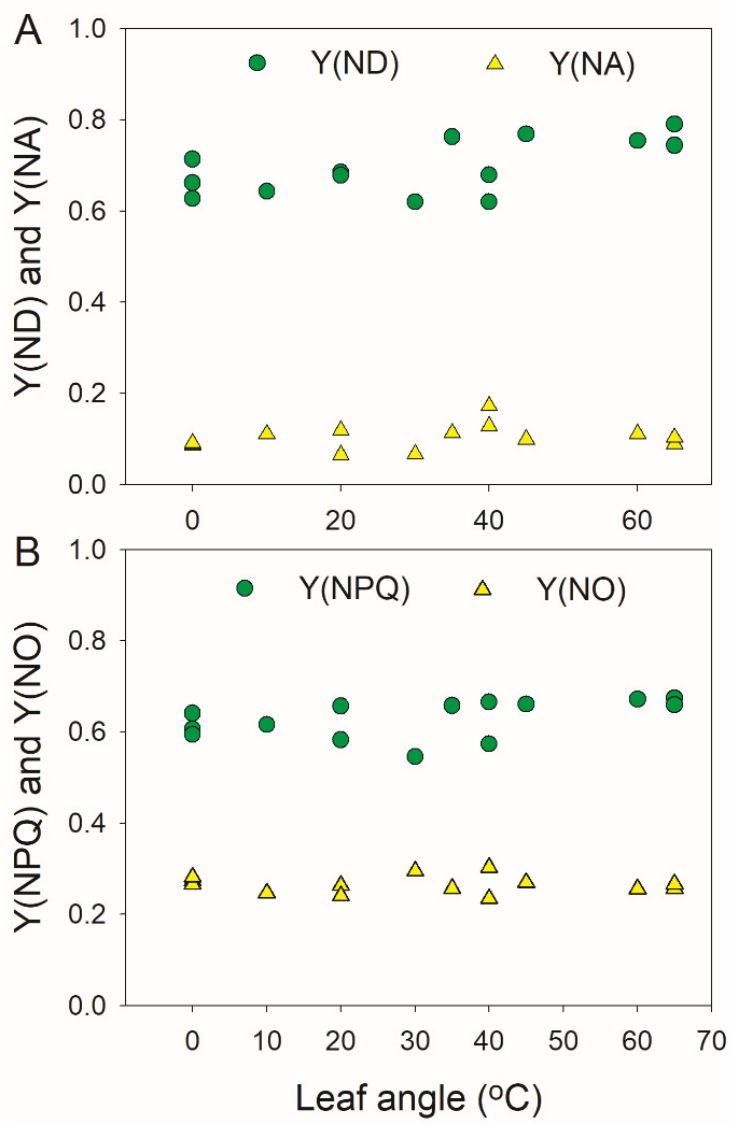
Figure 2. The relationships between the leaf angle and stable PSI ( A ) and PSII ( B ) parameters. After illumination at 1809- μ mol photons m − 2 s − 1 for 20 min, the steady-state PSI and PSII parameters were recorded. Y(ND), the quantum yield of PSI nonphotochemical energy dissipation due to donor-side limitation; Y(NA), the quantum yield of PSI nonphotochemical energy dissipation due to acceptor- side limitation; Y(NPQ), the quantum yield of regulatory energy dissipation in PSII; and Y(NO), the quantum yield of nonregulatory energy dissipation in PSII.